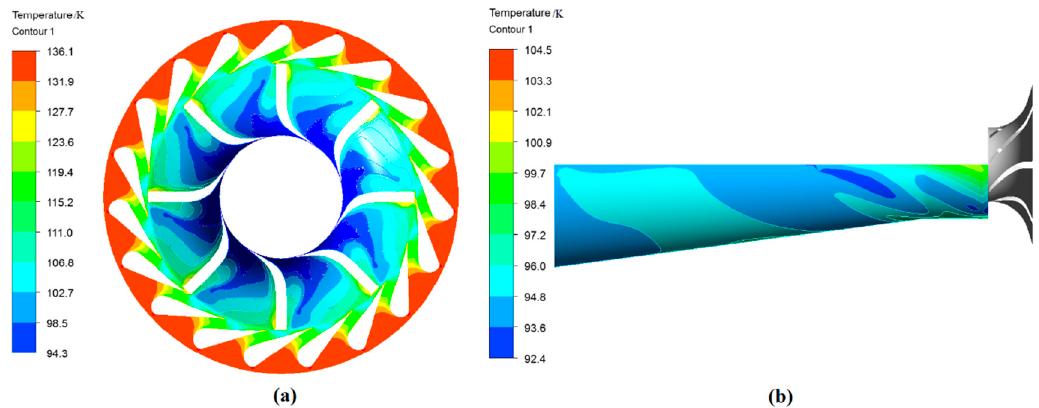
Appl. Sci. 2019 , 9 , 531 Figure 3. Temperature Contours of the expansion process under ε E = 4.53, u 1 / c s = 0.671: ( a ) Temperature contour in the nozzles and wheel; ( b ) temperature contour in the diffuser.